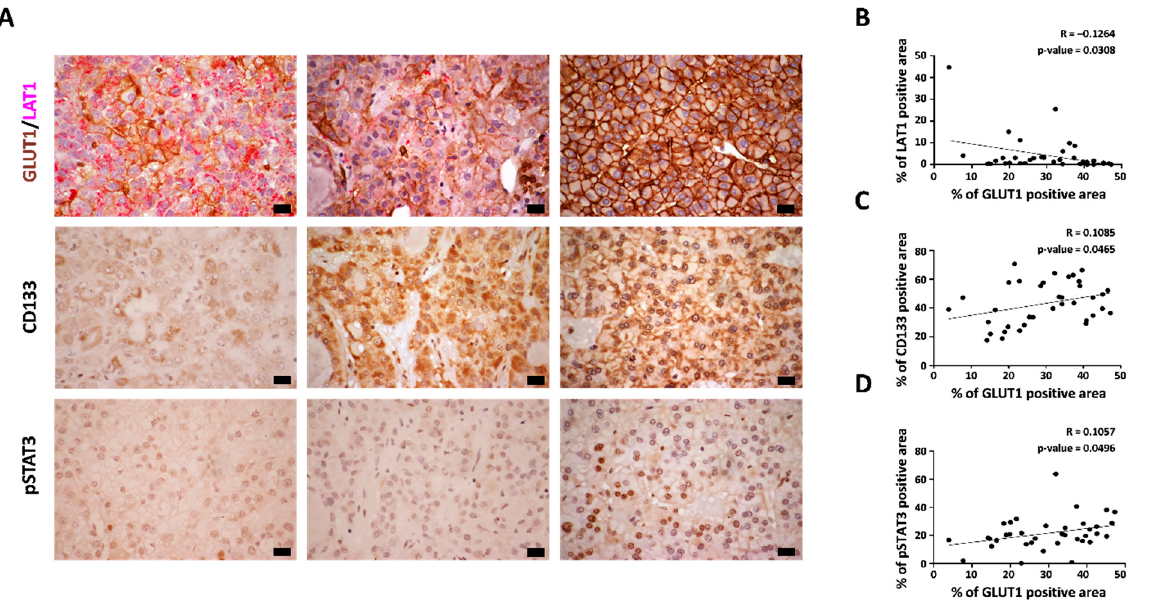
Figure 3. Expression levels of LAT1, GLUT1, CD133, and pSATA3 in human HCC tumor tissues. ( A ) Formalin-fixed, paraffin-embedded liver tissues from human patients with HCC were used. Double staining immunohistochemistry was conducted using GLUT1 and LAT1 antibodies. GLUT1 is indicated in brown and LAT1 is magenta pink. Single immunohistochemistry was also conducted using CD133 and pSTAT3 antibodies and counterstaining with hematoxylin. Scale bars: 20 μ m. ( B ) Correlation between the LAT1-positive area and GLUT1-positive area. ( C ) Correlation between the GLUT1-positive area and CD133-positive area. ( D ) Correlation between the GLUT1-positive area and pSTAT3-positive area. Pearson’s correlation coefficient was used to calculate the correlation between the two factors. Scale bars: 20 μ m.